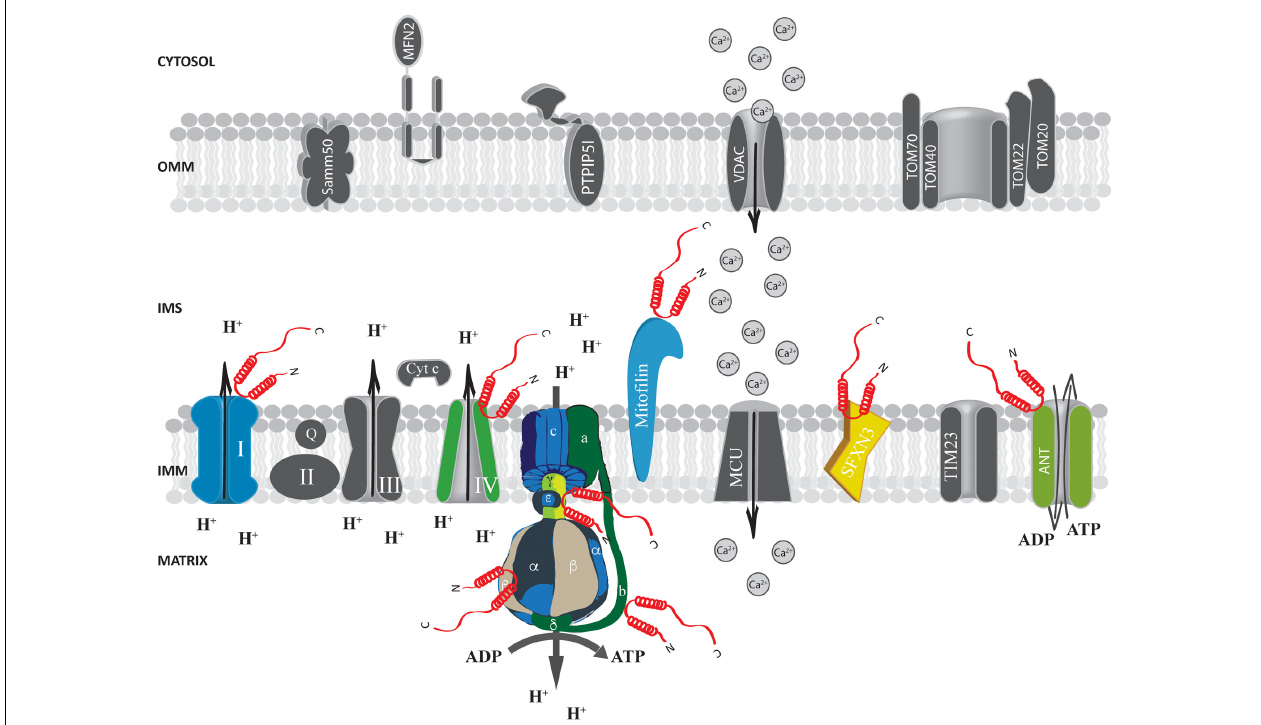
FIGURE 3 | Alpha-syn at the inter membrane space (IMS), inner mitochondrial membrane (IMM) and mitochondrial matrix. Picture shows α -syn binding partners at the IMS, IMM and mitochondrial matrix. The protein’s interactors are highlighted in colors. Alpha-syn is shown in